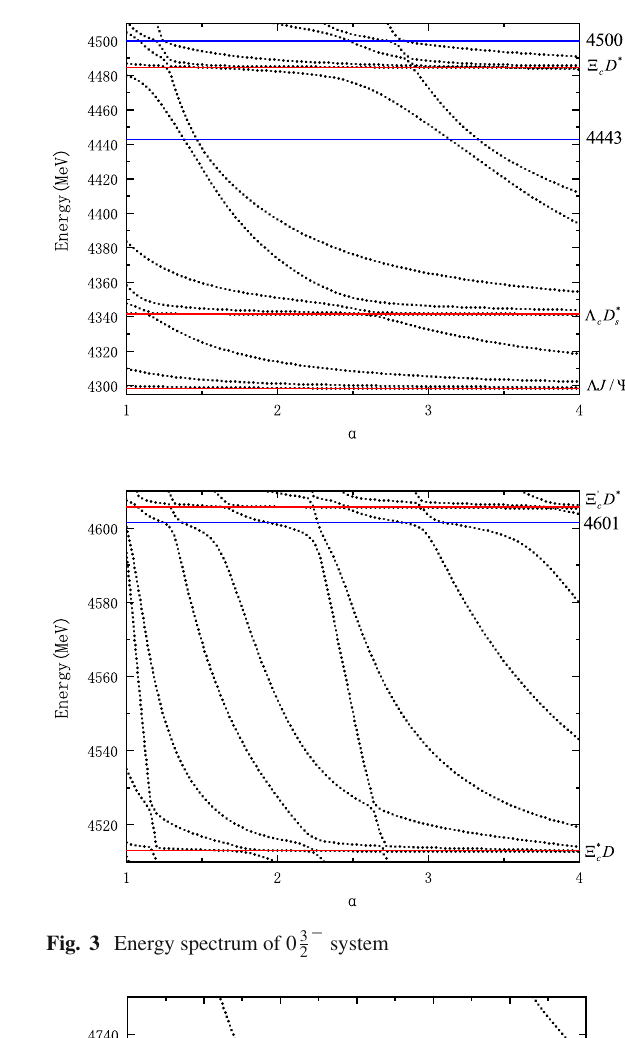
Fig. 2 Energy spectrum of 0 1